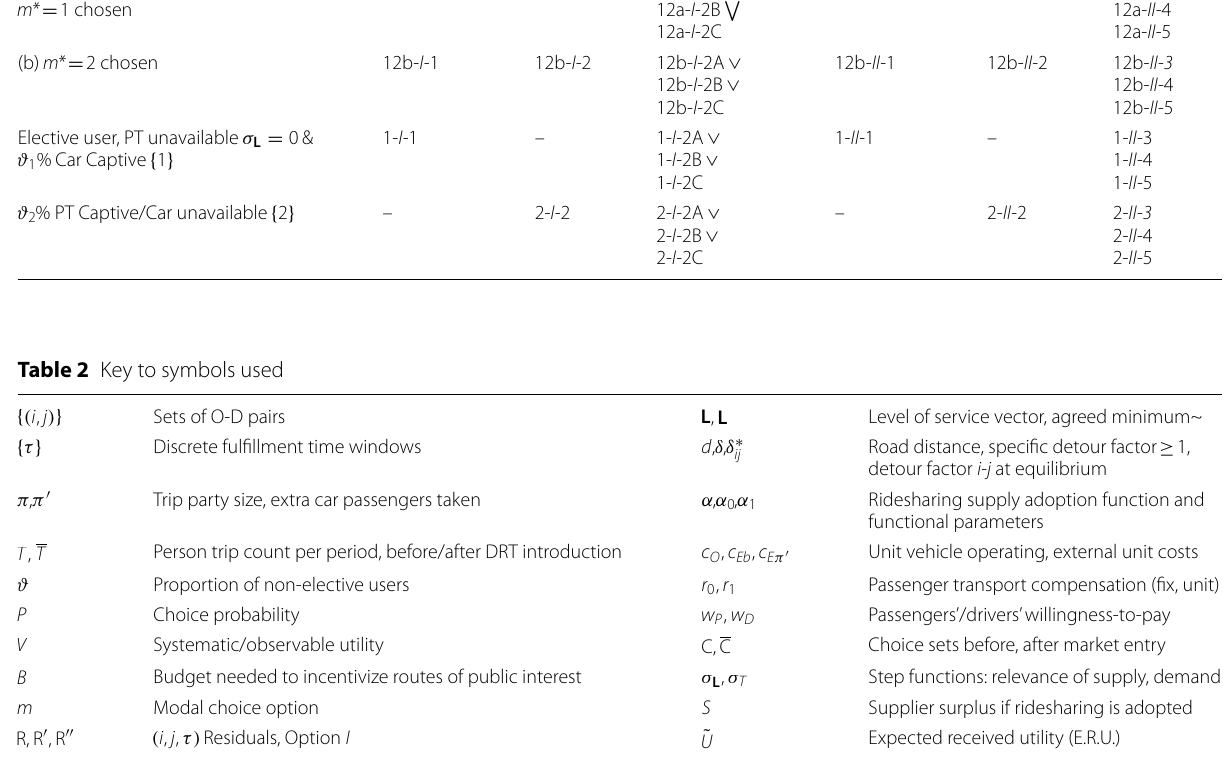
Table 1 Exhaustive case discrimination of 2 Scenario